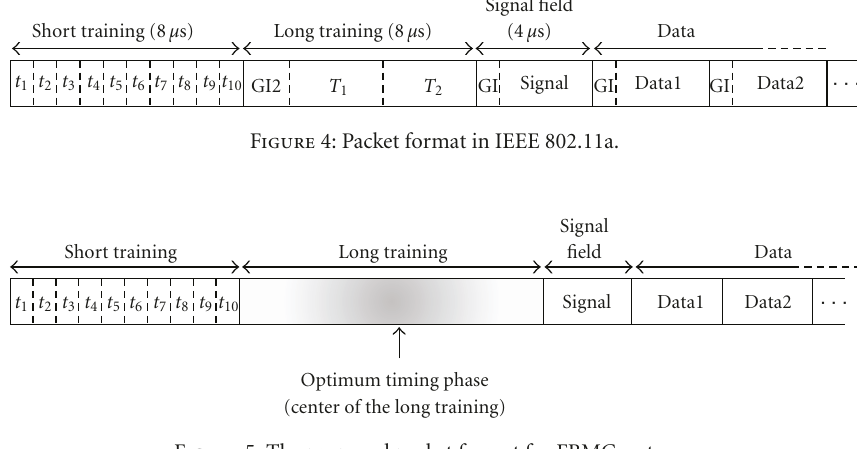
Figure 5: The proposed packet format for FBMC